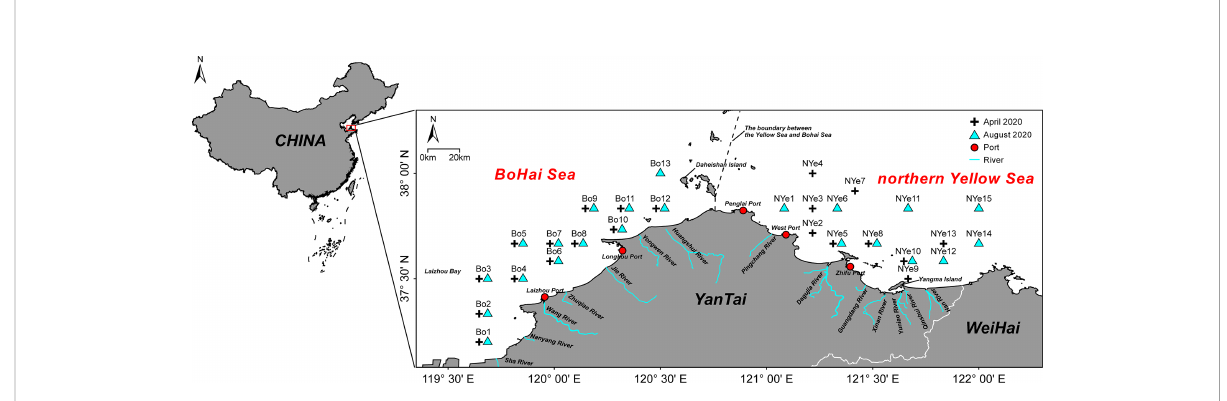
FIGURE 1 Map showing the study area and locations of the benthic sampling stations in the northern sea areas off Yantai,